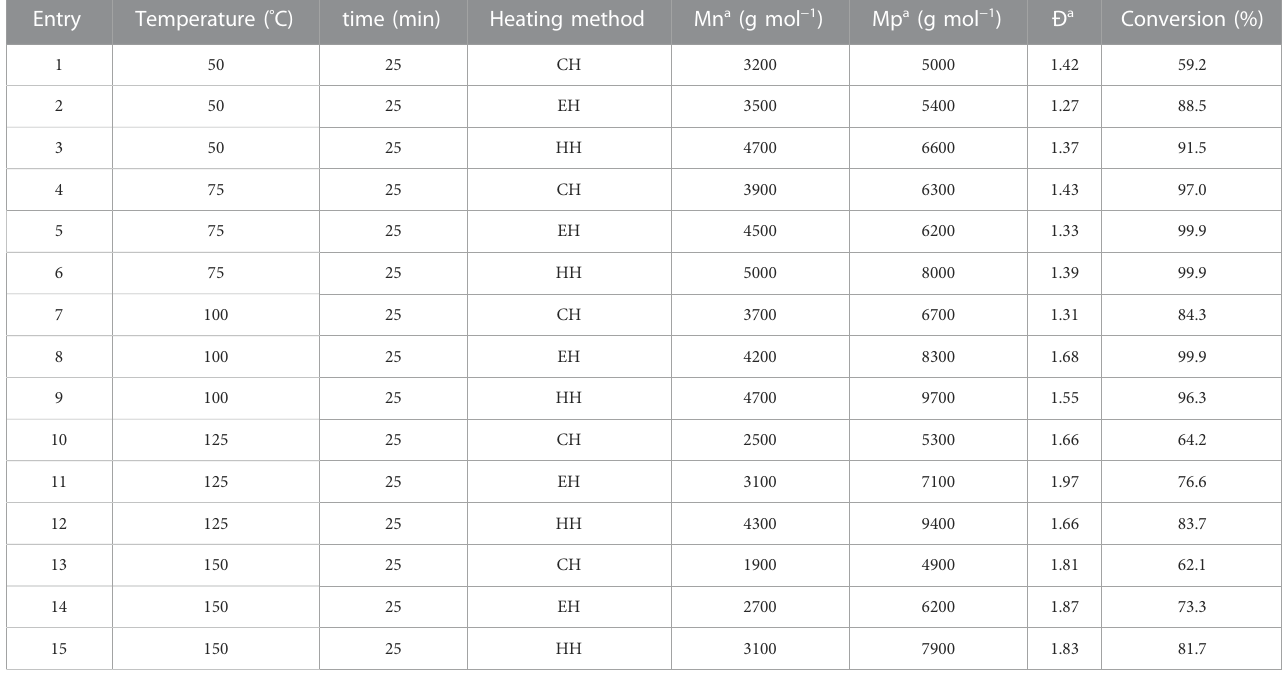
TABLE 1 Average results of ROP of CL with FeCl 3 and BzOH at various temperature at [M]:[C]:[I] ratio of 400:1:5. Entry Temperature ( °